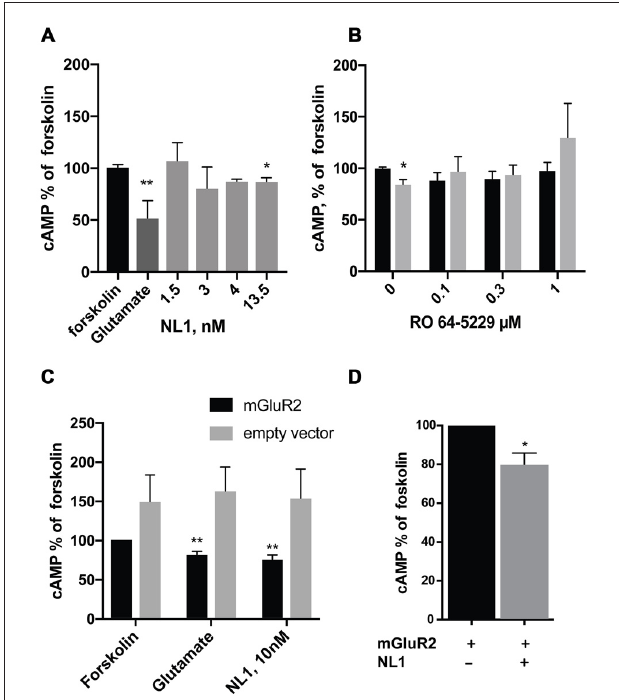
FIGURE 1 | Soluble neuroligin 1 (NL1) ectodomain reduces cyclic adenosine monophosphate (cAMP) levels via activation of metabotropic glutamate receptor 2 (mGluR2). (A) Soluble NL1 reduces cAMP levels in neurons. Hippocampal neurons were grown for 7 days and subsequently treated with 8 µ M forskolin and different concentrations of recombinant ecto-NL1 for 20 min. Glutamate was used as a positive control. Statistical significance was determined using Kruskal-Wallis test followed by the Dunn’s multiple comparison test ∗ p = 0.0344, ∗∗ p = 0.01; n = 3–7. (B) NL1 reduces cAMP levels via activation of mGluR2. Hippocampal neurons were grown for 7 days and subsequently treated for 20 min with 8 µ M forskolin only (black bars) or forskolin and recombinant ecto-NL1 (gray bars) in the presence of non-competitive mGluR2 inhibitor, RO 64-5229 in indicated concentrations. Statistical significance was determined using Friedman’s test followed by the Dunn’s multiple comparison test ∗ p = 0.0316, n = 4. (C) Soluble NL1 activates mGluR2 and decreases cAMP levels. HEK-293 cells were transfected with mGluR2-green fluorescent protein (GFP; black bars) or empty vector (gray bars) and then treated with 8 µ M forskolin and recombinant ecto-NL1 for 20 min. Statistical significance was determined using Kruskal-Wallis test followed by the Dunn’s multiple comparison test ∗ p = 0.0049; n = 5. (D) HEK-293 cells were double-transfected